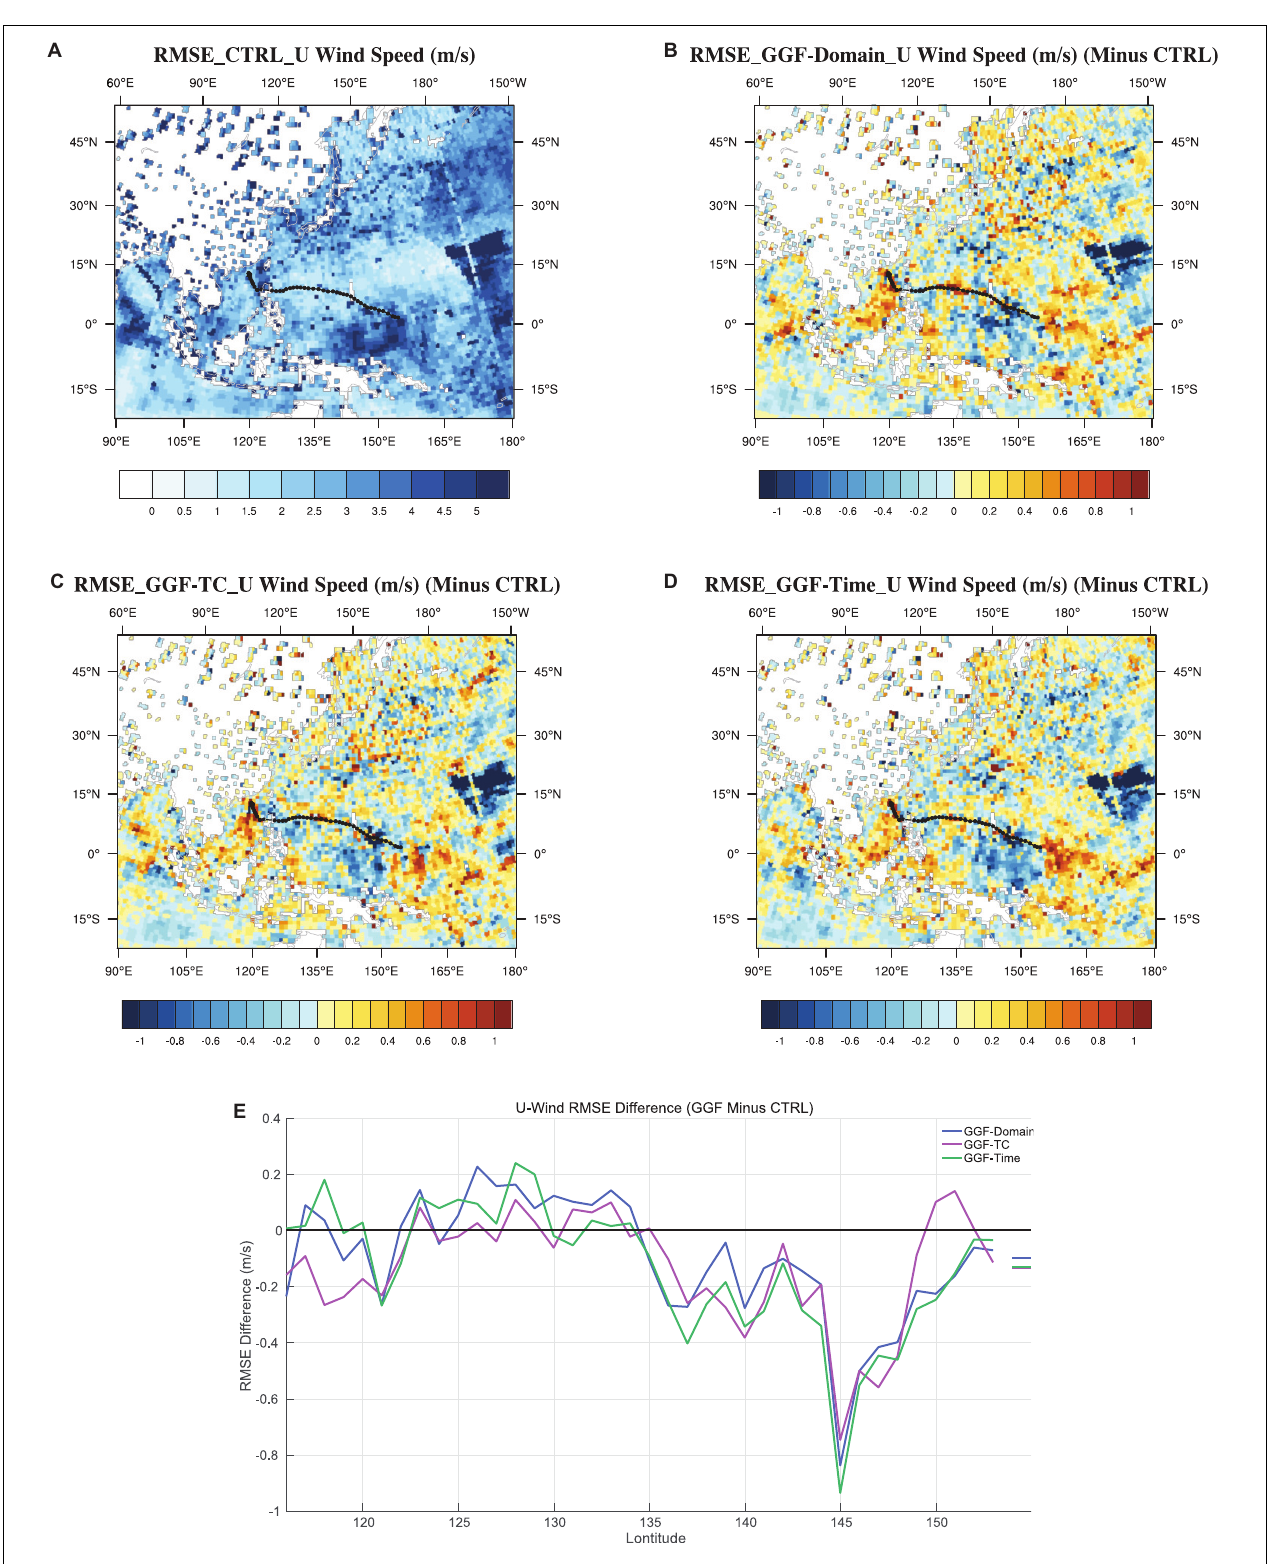
FIGURE 8 | Temporally and vertically averaged prior errors of u-wind (A) from experiment CTRL, and error differences (B) between experiments GGF-Domain and CTRL, (C) between experiments GGF-TC and CTRL, (D) between experiments GGF-Time and CTRL. The black line denotes the observed track of typhoon Yutu (2018). The averaged error differences along the TC track (3 degrees to the north and 13 degrees to the south) are shown in (E) , and the mean error differences are denoted on the side.